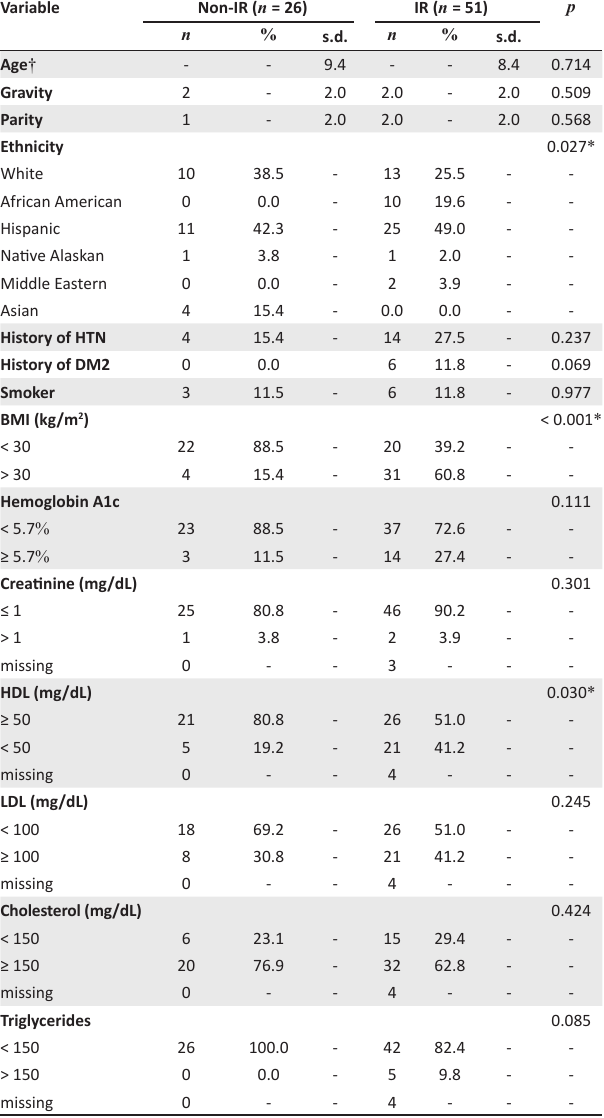
TABLE 3: Comparison of characteristics between IR and non-IR groups with IR defined as fasting insulin levels > 15 µiU/mL. Variable